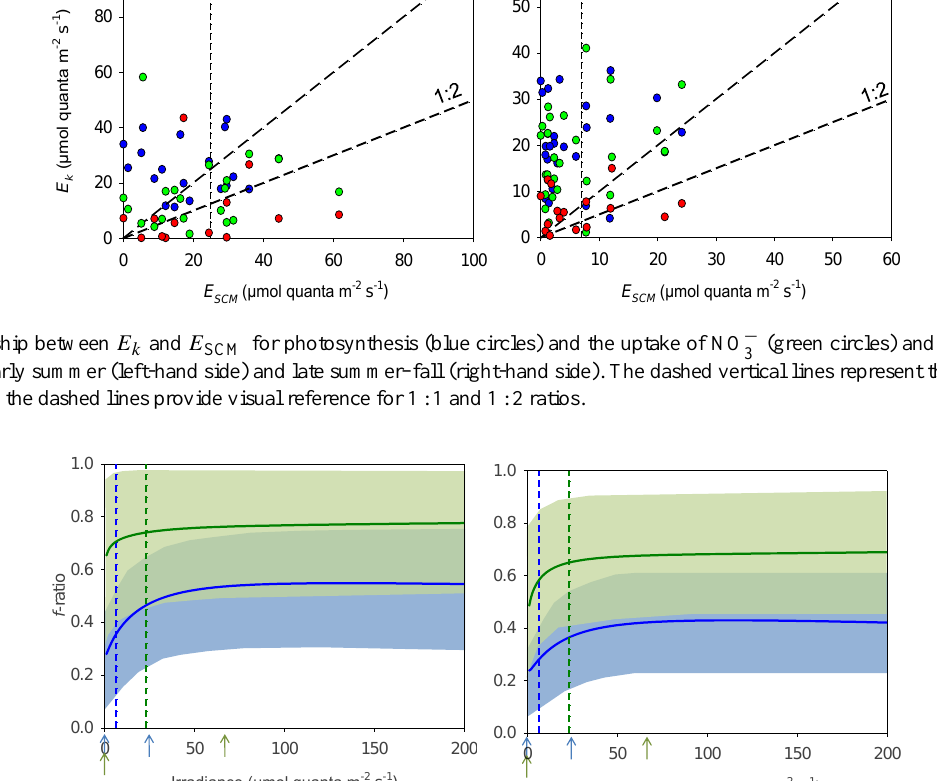
Fig. 7. Averages (solid lines) and ranges (shaded areas) of the f -ratio at the SCM as a function of incubation irradiance during spring–early summer (green) and late summer and early fall (blue), calculated with (right-hand side) or without (left-hand side) dark uptake ( D B ). Arrows and dashed lines give the range and mean of E SCM ,